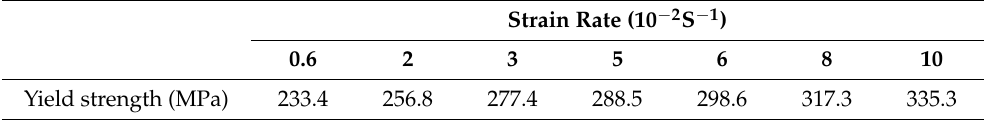
Table 3. Relevant parameters of quasi-static test.